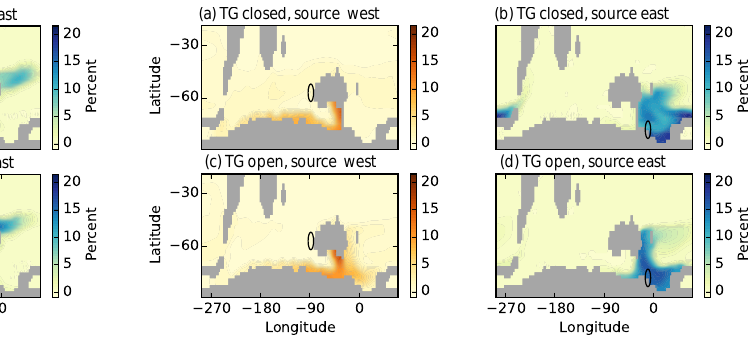
Figure 6. As Fig. 5, but for the Drake Passage open. When the Tasman Gateway (TG) is open, dinoflagellates released to the west of Australia enter the Australo-Antarctic Gulf and flow into the Ross Sea through the TG (c) . Species released near the Ross Sea may enter the gulf along the Antarctic coast (d) . We examine a snapshot taken 5 years after tracer